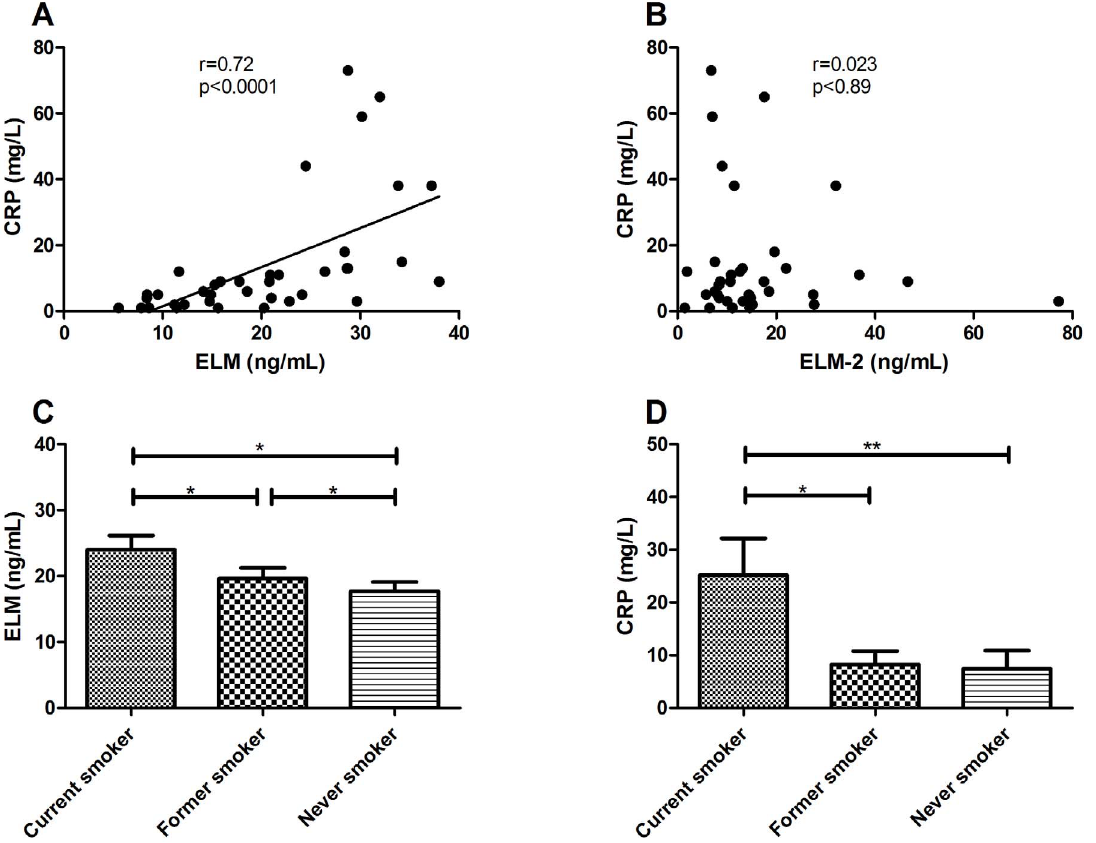
Figure 4. Correlations in the cardiovascular cohort. A) Spearman correlation between C-reactive protein and ELM, B) Spearman correlation between C-reactive protein and ELM-2. * p , 0.05, C) Biological validations of ELM versus smoking habits, D) Biological validations of C-reactive protein versus smoking habits. * p , 0.05; ** p , 0.01; C-reactive protein was only measured in the acute myocardial infarction (AMI) and non-AMI groups.